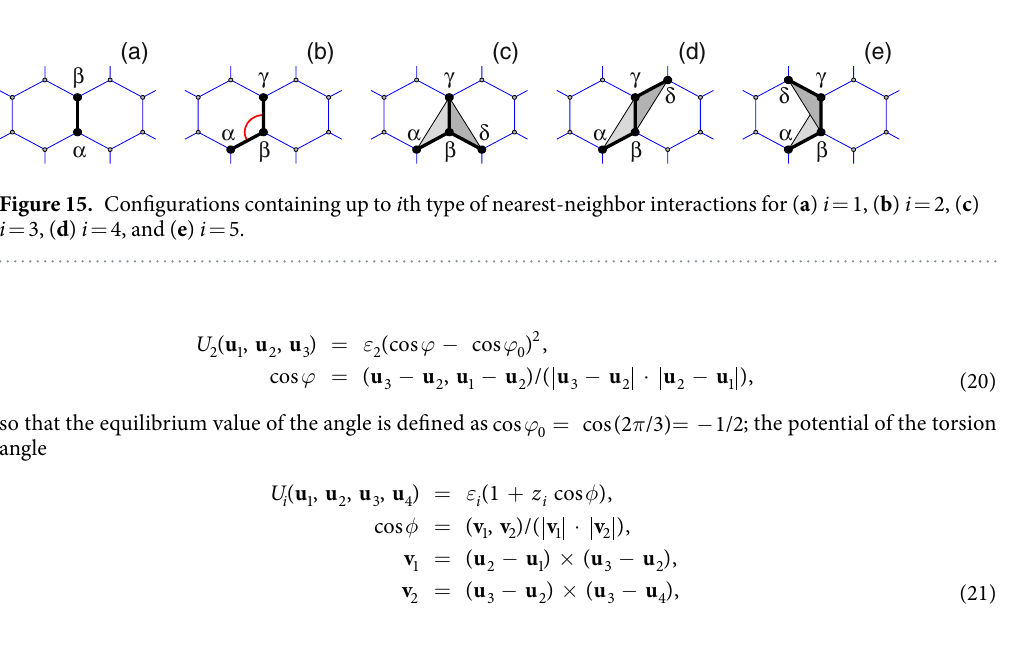
Figure 14. Schematic view of armchair nanoribbon with atom numbering. The edge atoms are shown as filled circles. Dotted lines separate the elementary cells of the nanoribbon. N e = 4 K + 2 is the number of atoms in the elementary cell. Width of the nanoribbon D = 1.23 nm, the number of full hexagons in the cell K = 5.